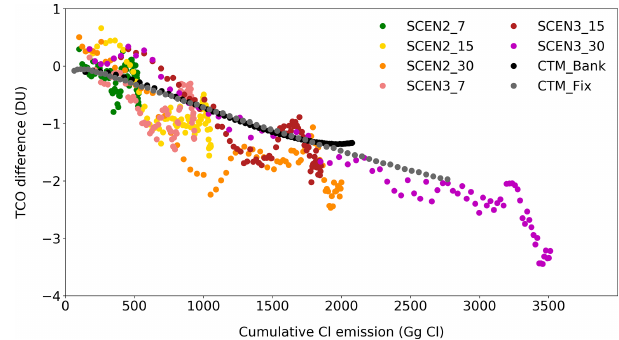
Figure 6. TCO return date (defined as the date at which 60 ◦ S– 60 ◦ N averaged TCO values return to the 1960–1980 average) for the BASE and SCEN simulations versus Cl y return date (defined as the date at which Cl y mixing ratios at 40km, averaged from 10 ◦ S– 10 ◦ N, return to the 1980 BASE value). The dashed line gives the linear fit through the points.